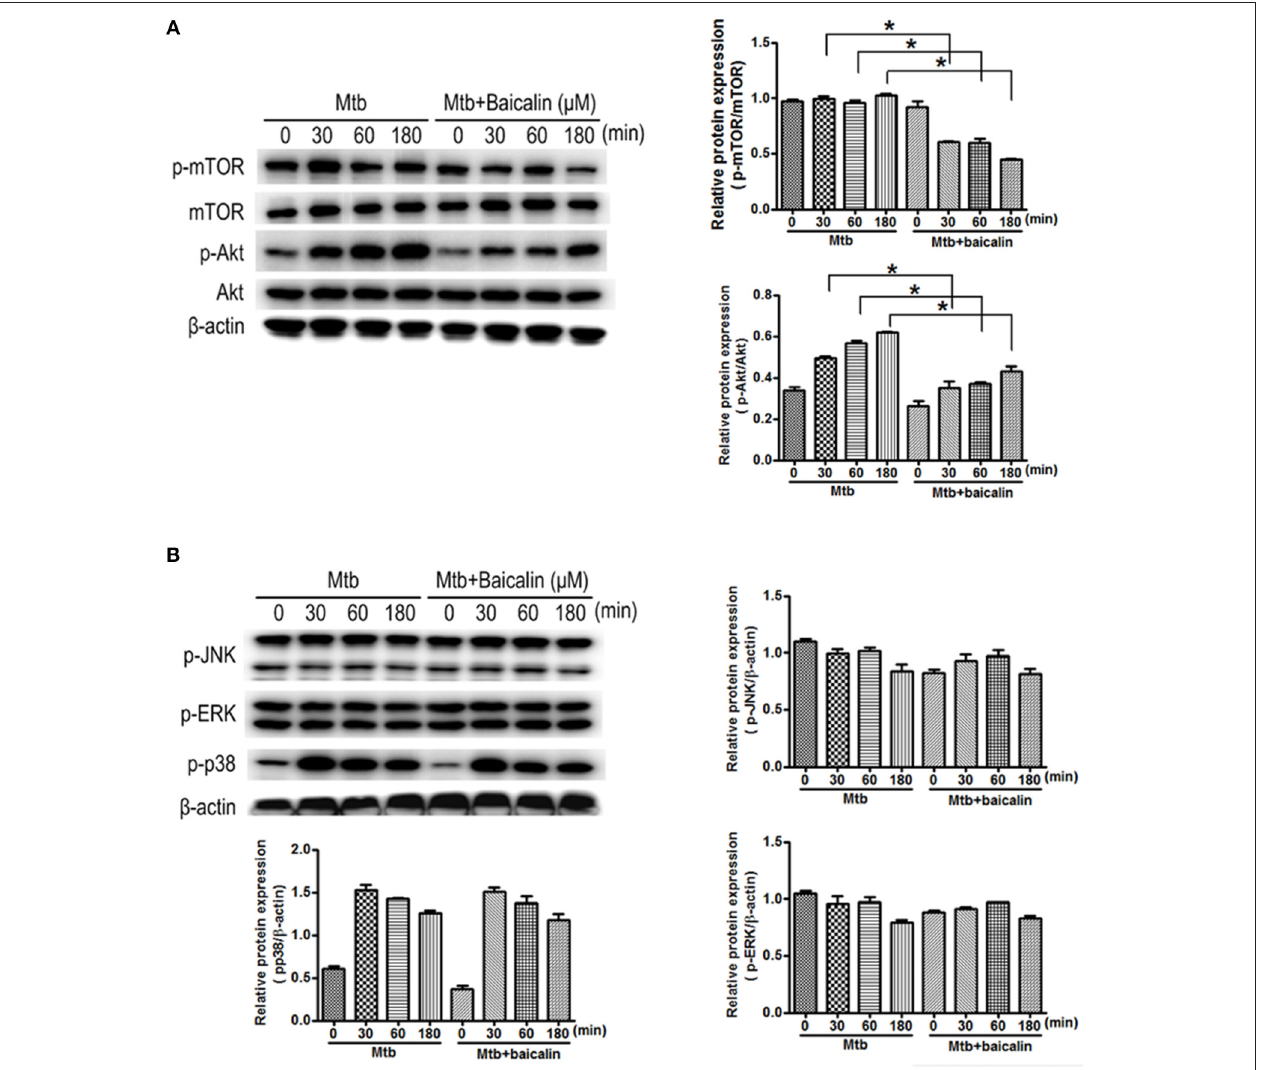
FIGURE 8 | Bacalin suppresses the PI3K/Akt/mTOR pathway but has no effect on the MAPK signaling in primary peritoneal macrophage cells. (A) Western blot analysis of mTOR, p-mTOR, Akt, and p-Akt expression in primary peritoneal macrophage cells. β -actin was used as a control. The right bar graphs show the statistical results for the relative quantitative expression of p-Akt and p-mTOR. (B) Western blot analysis of p-JNK, p-ERK, and p-p38 expression in peritoneal macrophage cells. The right and below bar graphs show the statistical results for the relative quantitative expression of p-p38, p-ERK, and p-JNK. Data are shown with the means ± SD of at least three independent experiments. * p <